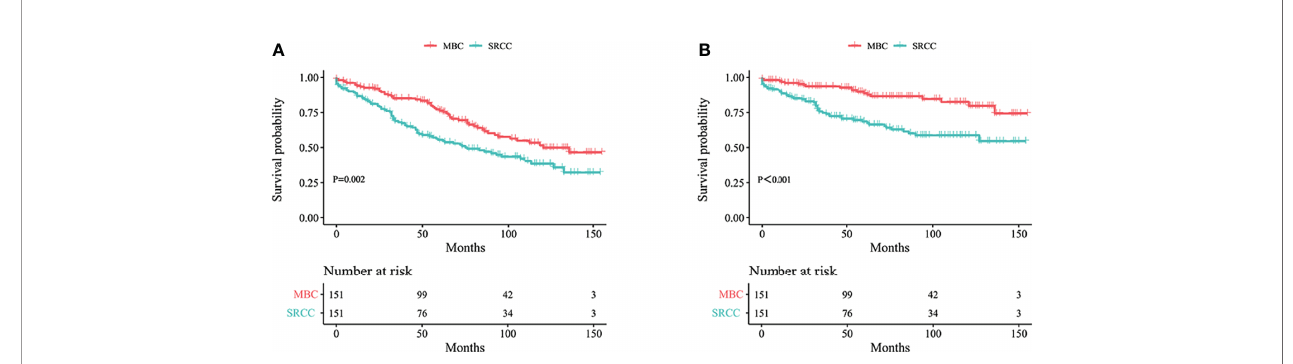
FIGURE 3 | Kaplan – Meier curves: OS (A) and BCSS (B) among SRCC and MBC after PSM. OS, overall survival; BCSS, breast cancer-speci fi c survival; SRCC, primary breast signet ring cell carcinoma; MBC, mucinous breast adenocarcinoma; PSM, Propensity Score Matching.